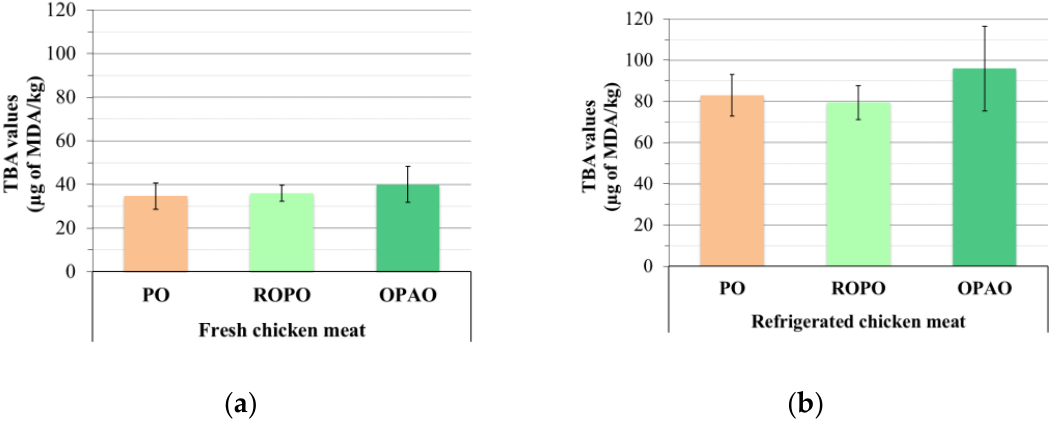
Figure 1. Thiobarbituric acid (TBA) values (µg of malondialdehyde (MDA)/kg) of ( a ) fresh and ( b ) refrigerated dark chicken meat with skin coming from the different diets (PO, crude palm oil; ROPO, refined olive pomace oil; OPAO, olive pomace acid oil). The results were represented as mean ± standard deviation (n = 8).